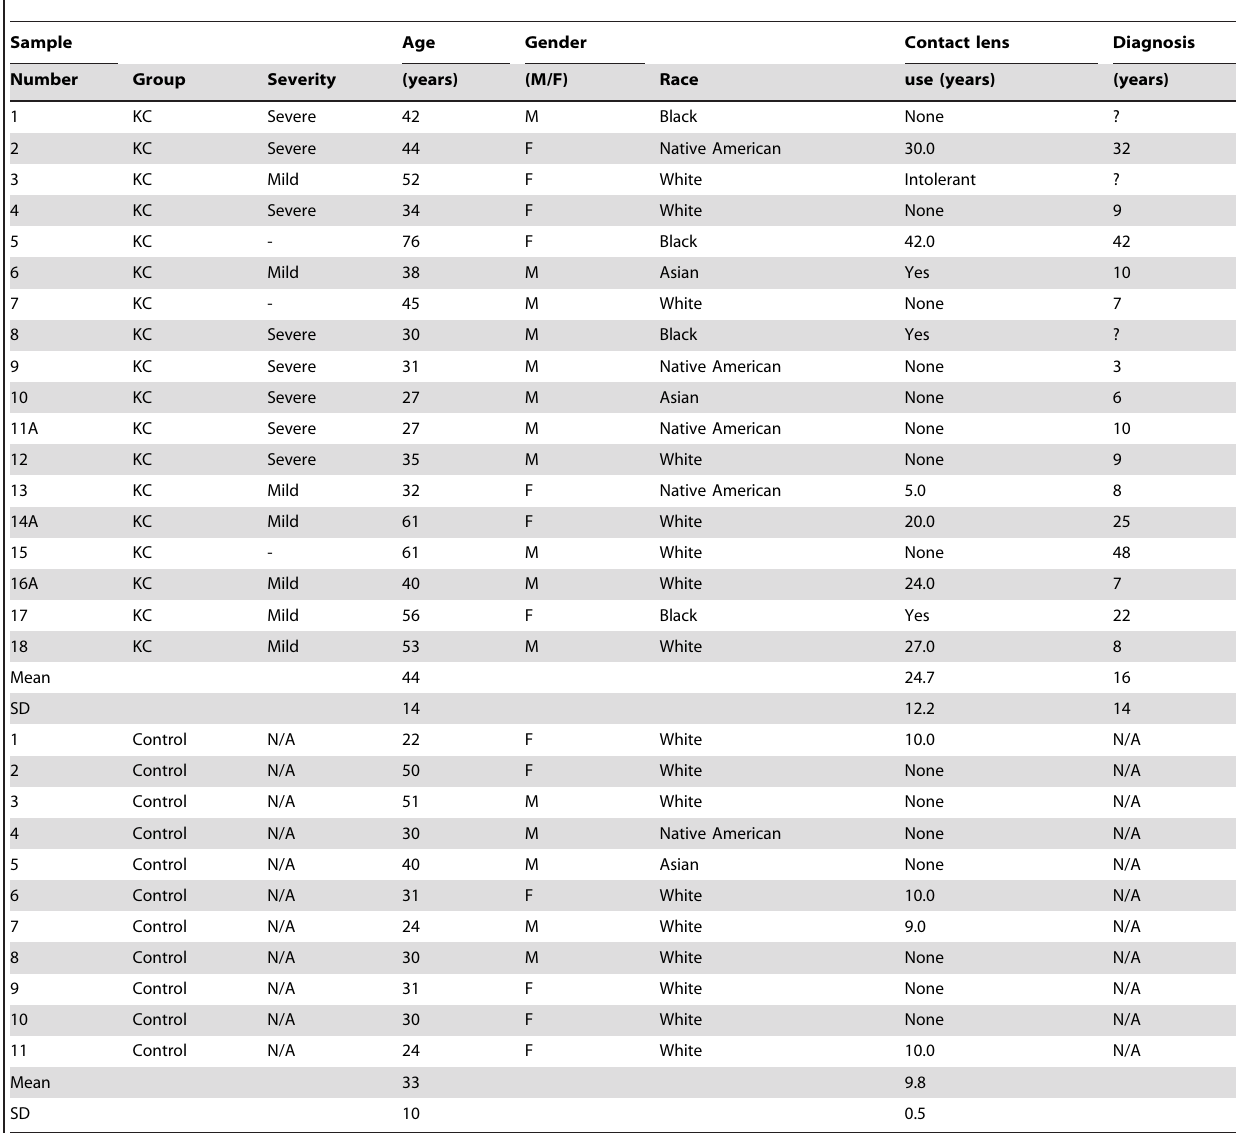
Table 1. Keratoconus and control samples for immuno-bead multiplex ELISA.